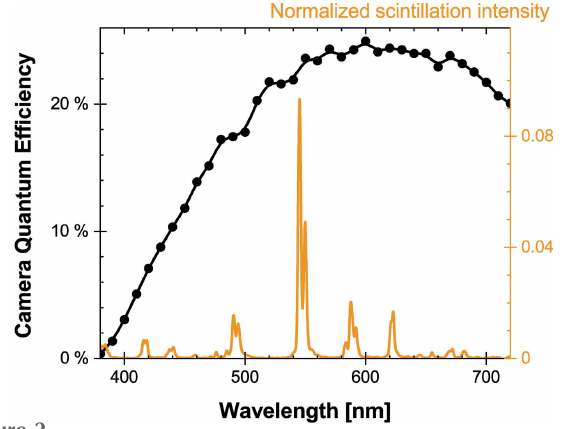
Figure 2 Quantum efficiency of the Zyla-HF camera (equipped with a fiber-optics plate) and an emission spectrum of a GOS:Tb scintillating screen. A convolution of both curves yields QE sys = 21.0%.